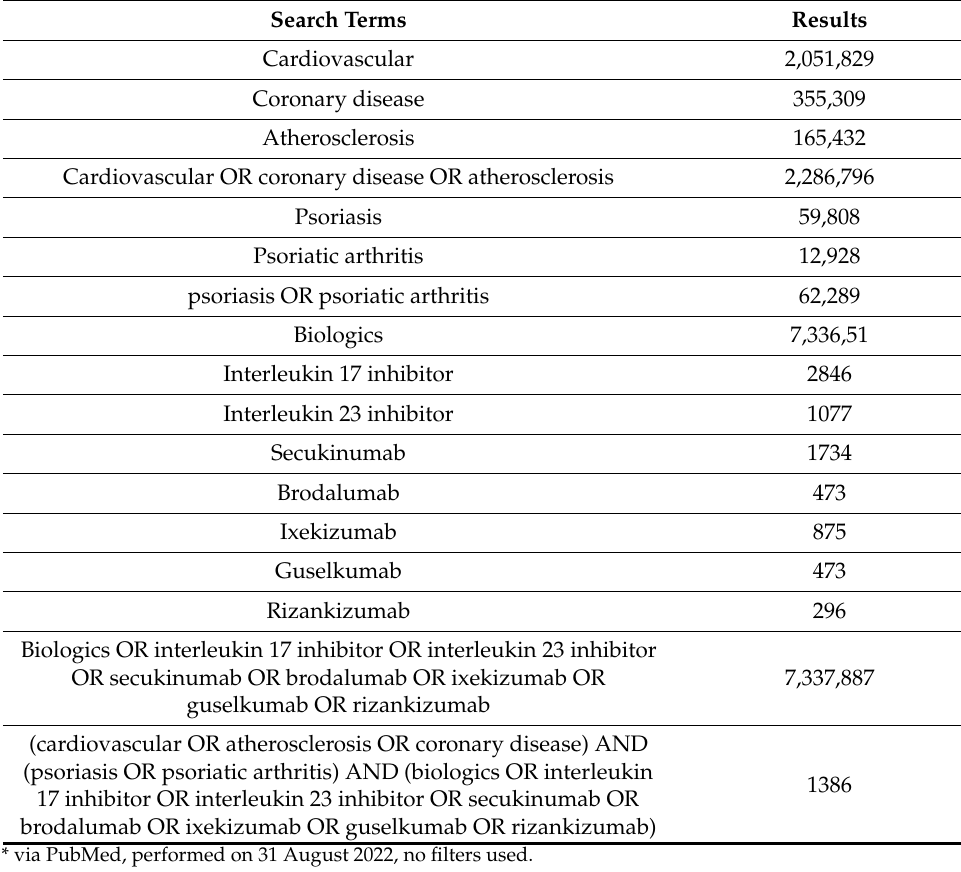
Table 1. MEDLINE search strategy *.